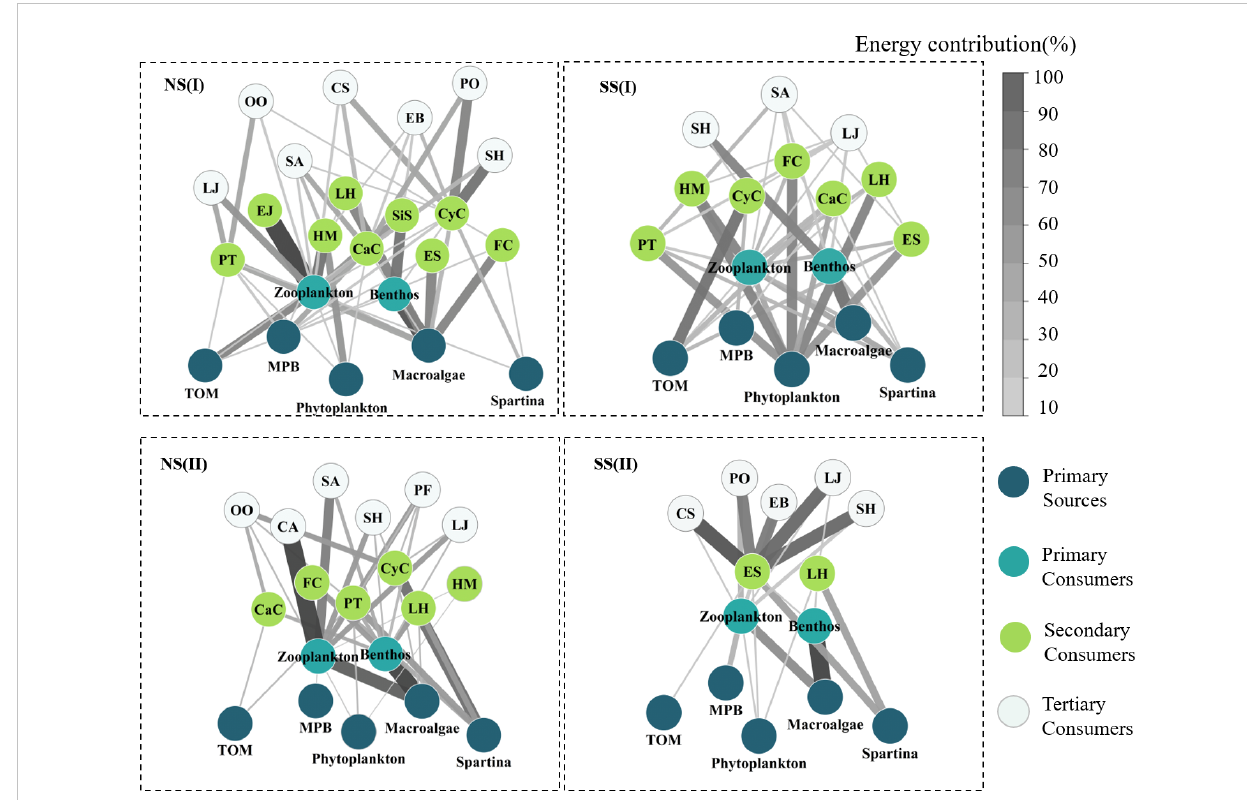
FIGURE 8 Energy fl ow of food webs for each sampling site during the fl ood and non- fl ood seasons. Arrow thickness represented the probability of the food source contributed to an upper consumer. (I)Flood season; (II)Non- fl ood season; (NS)Northern shore; (SS)Southern shore (abbreviation in Table 1).